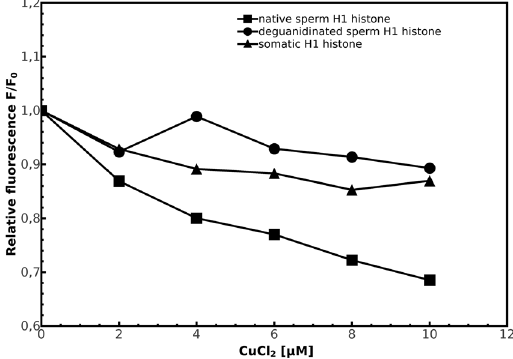
Figure 6. Relative fluorescence plot F/F 0 of ANS-H1 histones complex in presence of increasing concentrations of CuCl 2 in the range from 0 to 10 μ